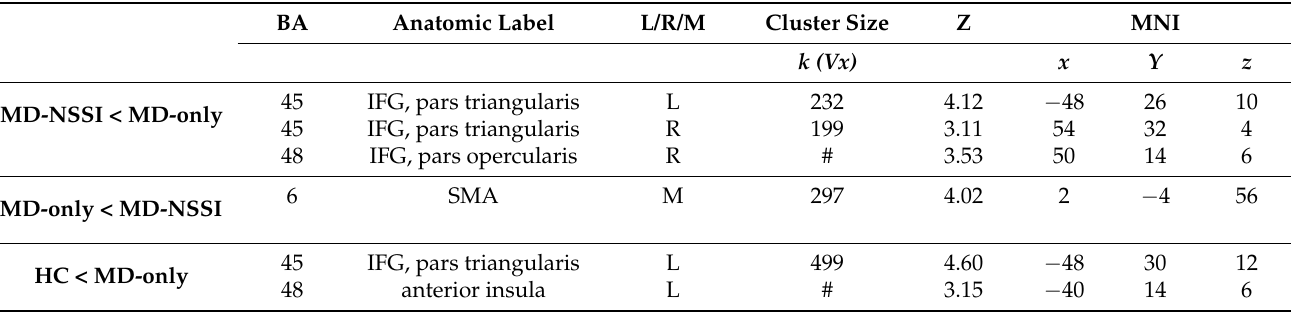
Table 4. Significant ( p ≤ 0.05; minimum cluster size of 183 contiguously significant voxels at p < 0.005, uncorrected) between-group differences in differential neural activations from the contrast ‘incorrect minus correct incongruent Go trials’ corresponding to neural error signaling. Depressed adolescents with comorbid non-suicidal self-injury (MD-NSSI; n = 14); adolescents with major depression (MD- only; n = 13); healthy controls (HC; n =